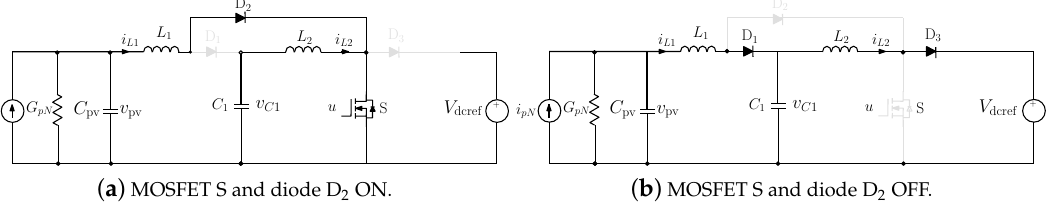
Figure 5. The two simplified equivalent circuit configurations of the system of Figure 2 for the different switch S states where the PV generator is substituted by its linearized Norton equivalent and the grid-interlinked inverter is substituted by a constant DC